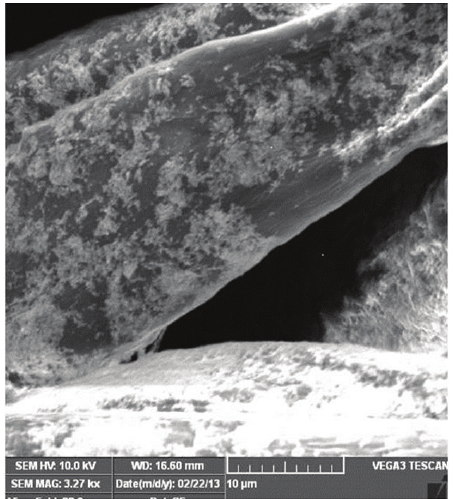
Figure 4: SEM image of nanosilver fabricated onto the cotton cloth